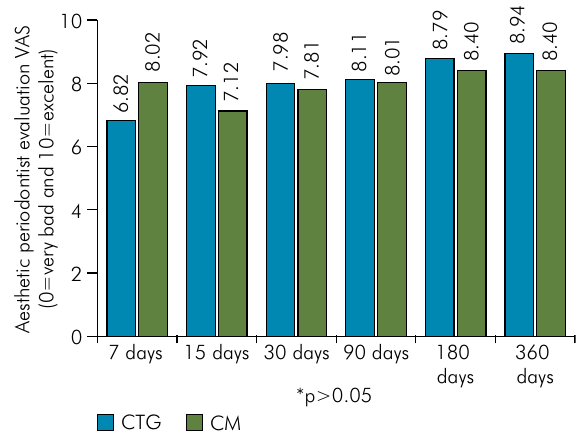
Figure 3. Aesthetic patient evaluation VAS (0= very bad and 10=excelente).